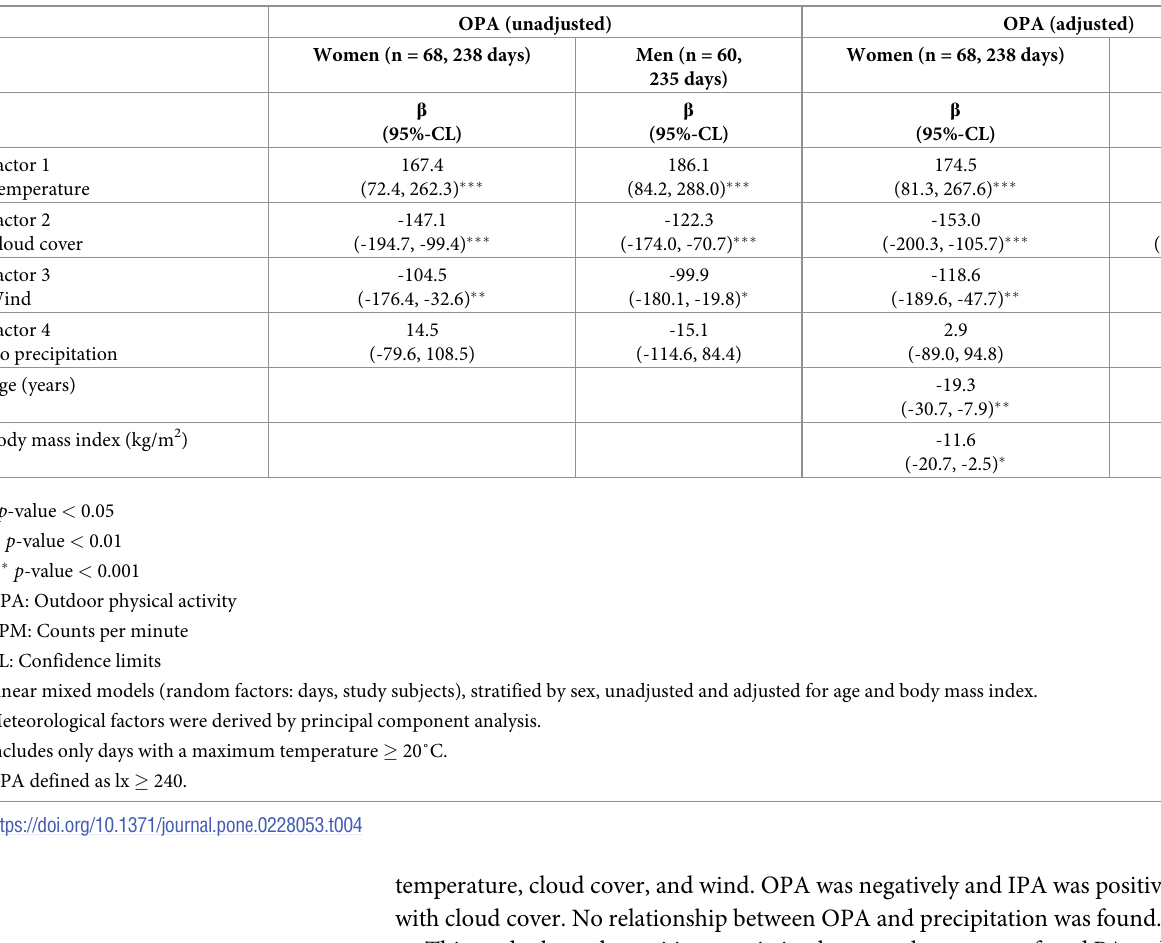
Table 4. Association of OPA (average accelerometer CPM) and meteorological